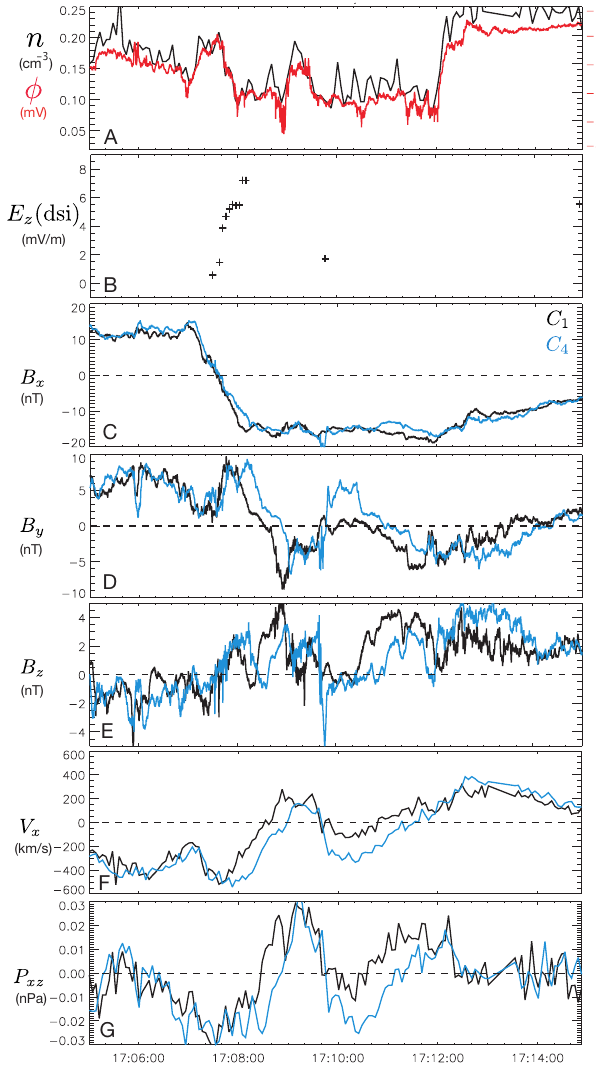
Fig. 2. Overview of the data measured by Cluster 1 and 4 spacecraft on 18 August 2002. Vectors are presented in the GSM coordinate